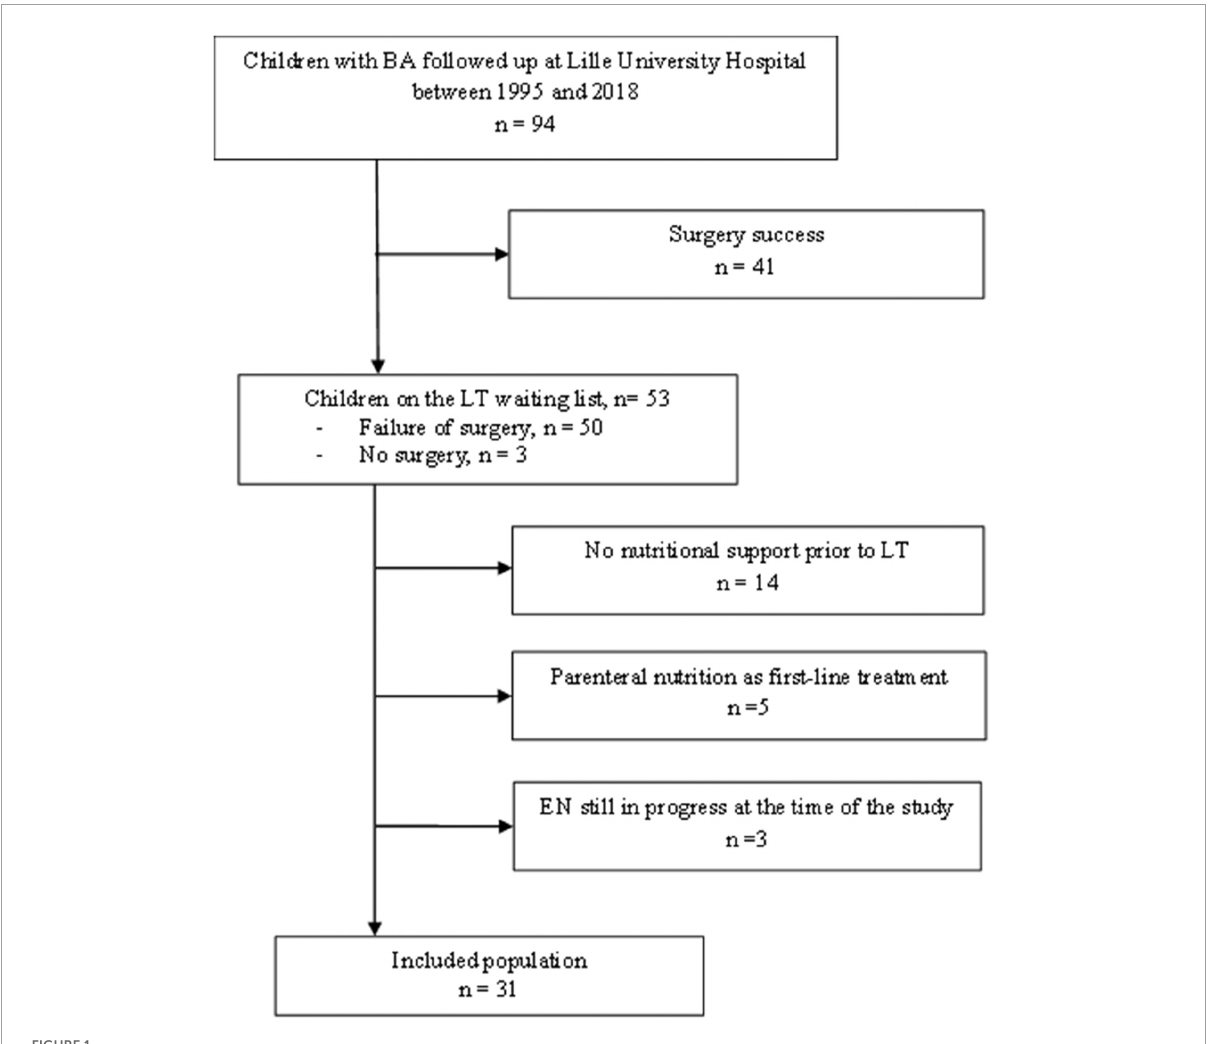
FIGURE1 Study flow-chart. BA, biliary atresia; LT, liver transplantation.